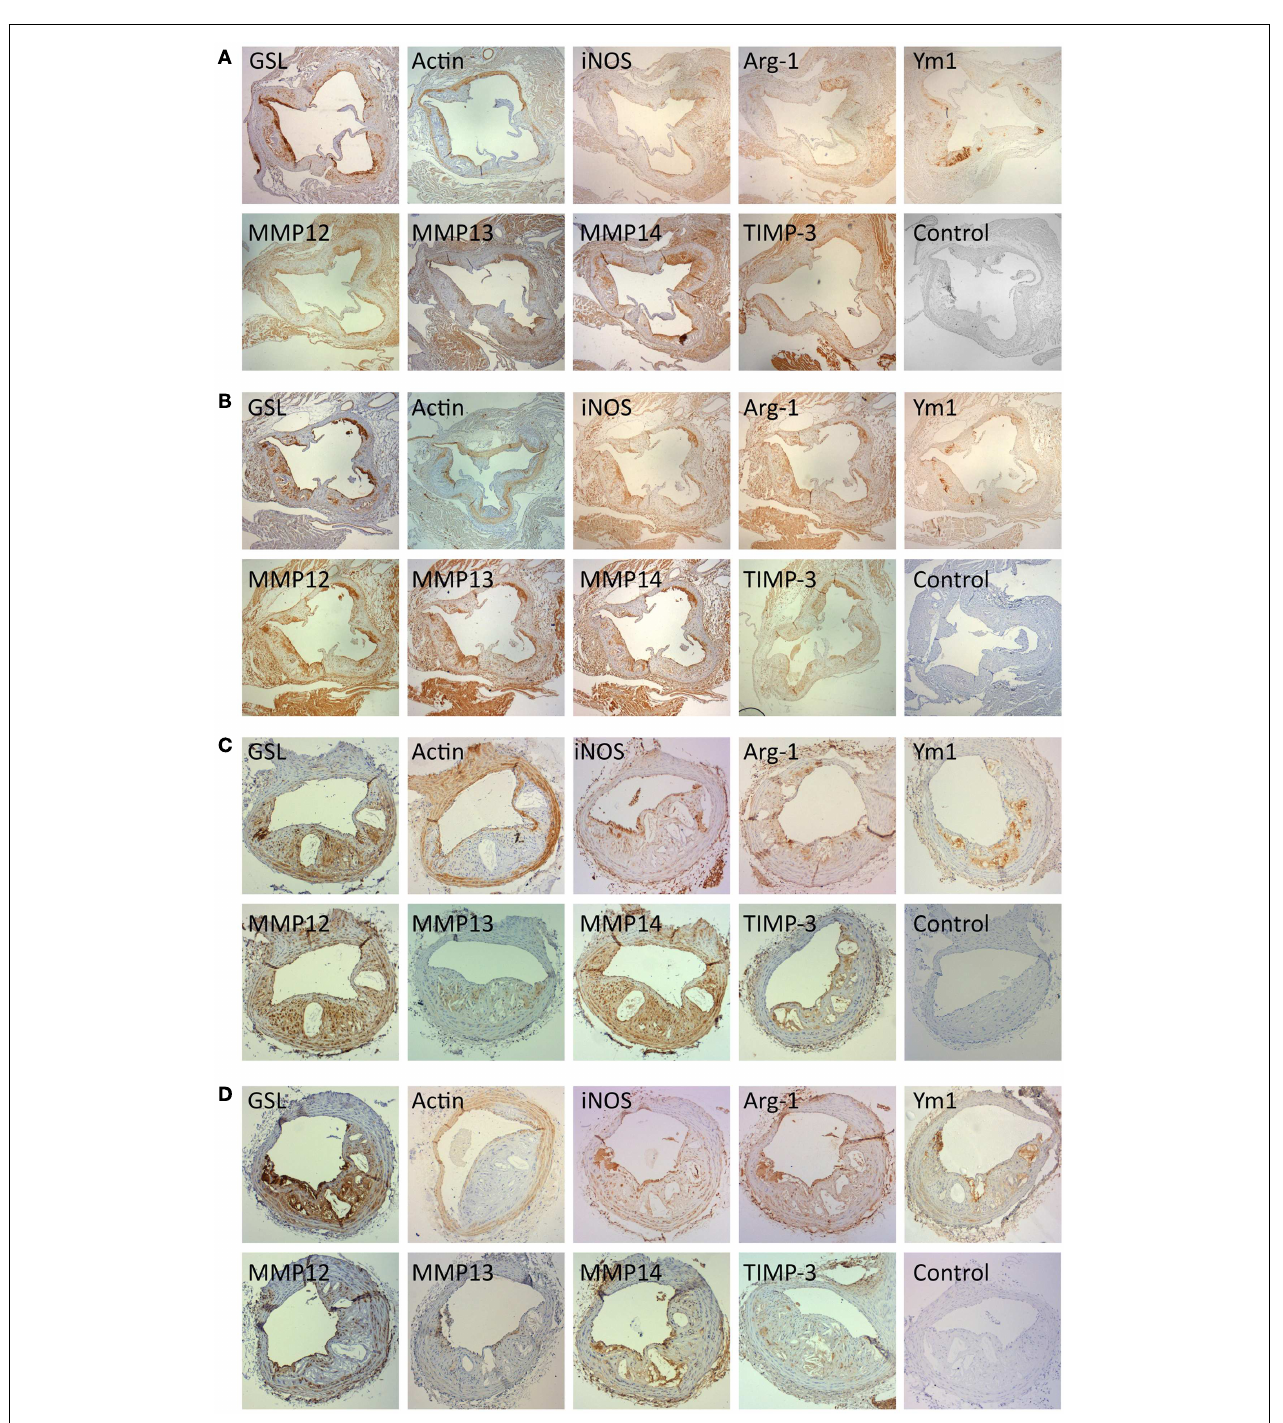
FIGURE 7 | Immunohistochemical staining for cell type, M1 and M2 markers and for MMPs andTIMPs . Near consecutive sections to the section stained with elastin/van Gieson (EVG) were subjected to immunohistochemistry for macrophages [ Griffonia simplicifolia lectin II (GSL)], smooth muscle cells ( α -smooth muscle actin; actin), iNOS, arg-1,Ym-1, MMP-12, MMP-13, MMP-14, andTIMP-3, using the antibodies detailed in